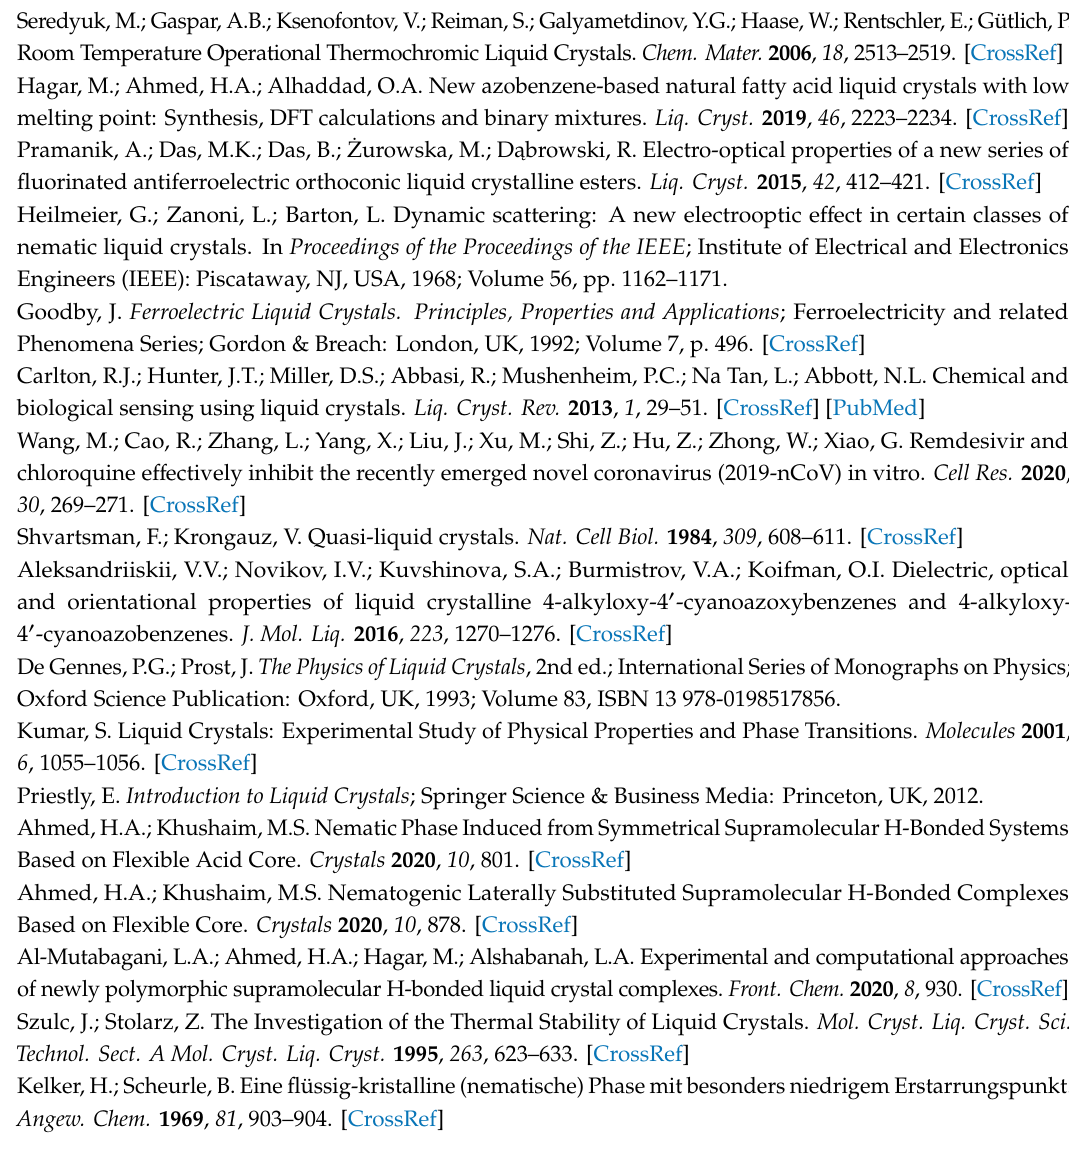
Table S1. 1 H-NMR chemical shifts, Figure S1. 1 H-NMR of (4-methoxybenzylideneamino)phenyl oleate at 305 K. Figure S2. 13 C-NMR of (4-methoxybenzylideneamino)phenyl oleate at 305 K. Figure S3. HSQC-NMR of (4-methoxybenzylideneamino)phenyl oleate at 305 K. Figure S4. 1 H-NMR of (4-methoxybenzylideneamino)phenyl oleate at 310 K. Figure S5. 1 H-NMR of (4-methoxybenzylideneamino)phenyl oleate at 315 K. Figure S6. 1 H-NMR of (4-methoxybenzylideneamino)phenyl oleate at 320 K. Figure S7. 1 H-NMR of (4-methoxybenzylideneamino)phenyl oleate at 325 K. Figure S8. 1 H-NMR of (4-methoxybenzylideneamino)phenyl oleate at 335 K. Figure S9. 1 H-NMR of (4-methoxybenzylideneamino)phenyl oleate at 345 K. Figure S10. 1 H-NMR of (4-methoxybenzylideneamino)phenyl oleate at 355 K. Figure S11. 1 H-NMR of (4-methoxybenzylideneamino)phenyl oleate at 365